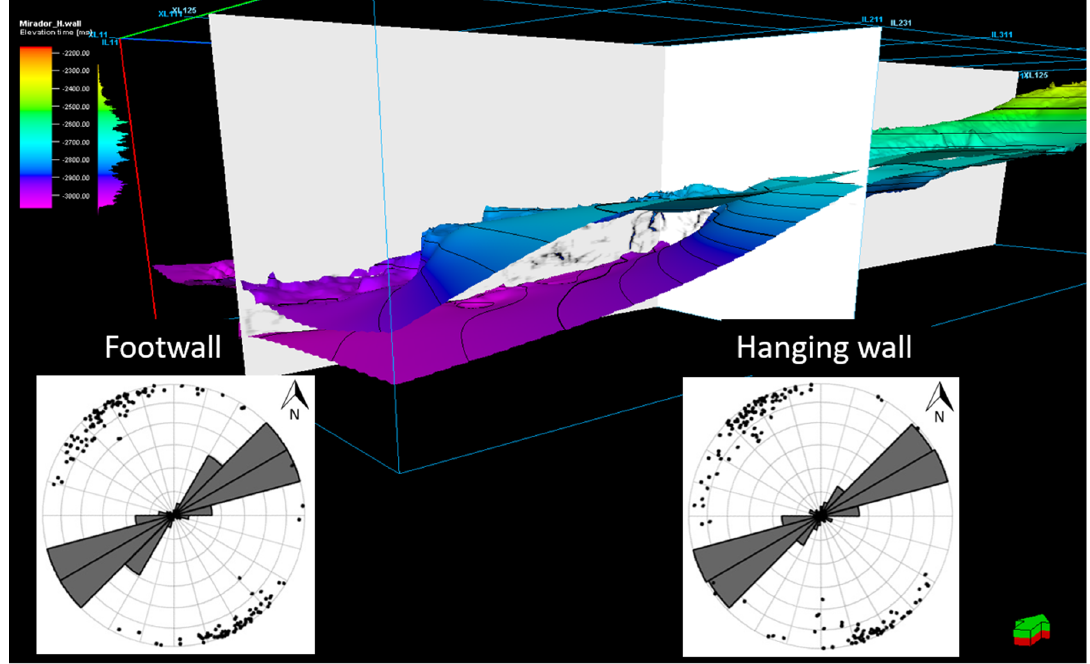
Figure 13. Ant-tracking data cropped between two surfaces to extract reservoir horizon fractures in Mirador Fm. The insets are rose diagrams showing the orientation of the Mirador Fm ant-tracking fractures in the hanging wall and the footwall.